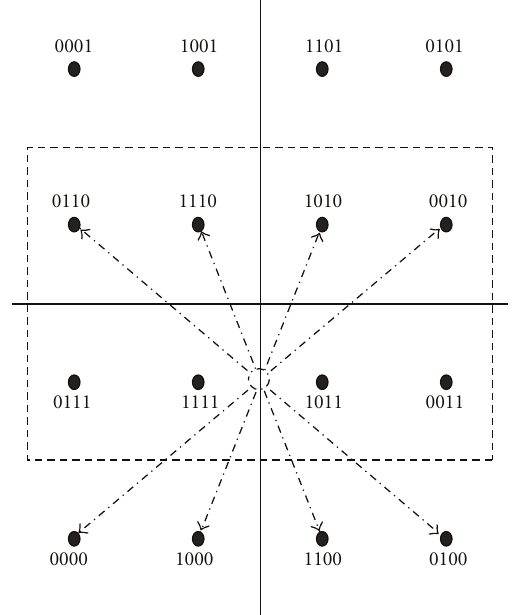
Figure 3: 16-ary QAM modulation with Gray coding.